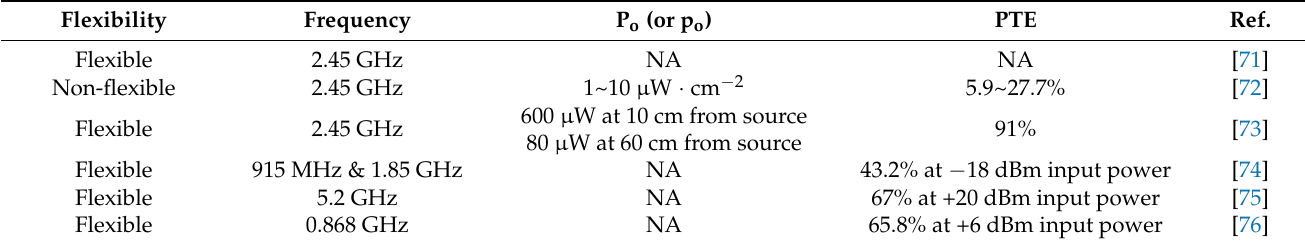
Table 6. Comparison of typical RF harvesters used for wearable